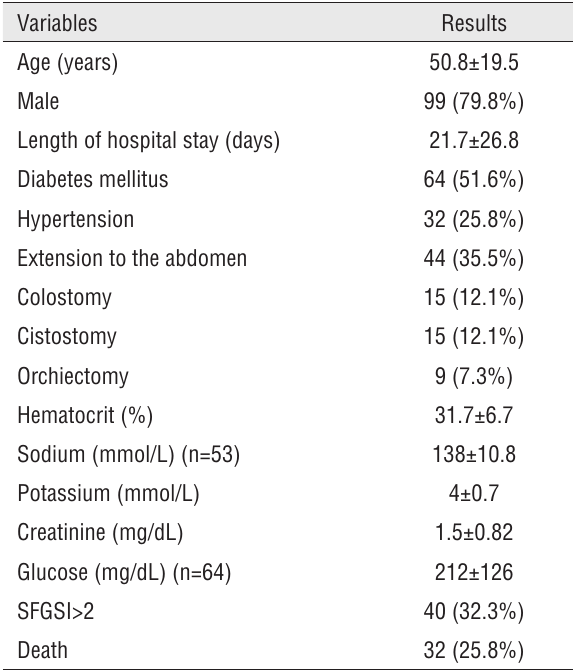
Table 1 - Main Clinical and laboratory data